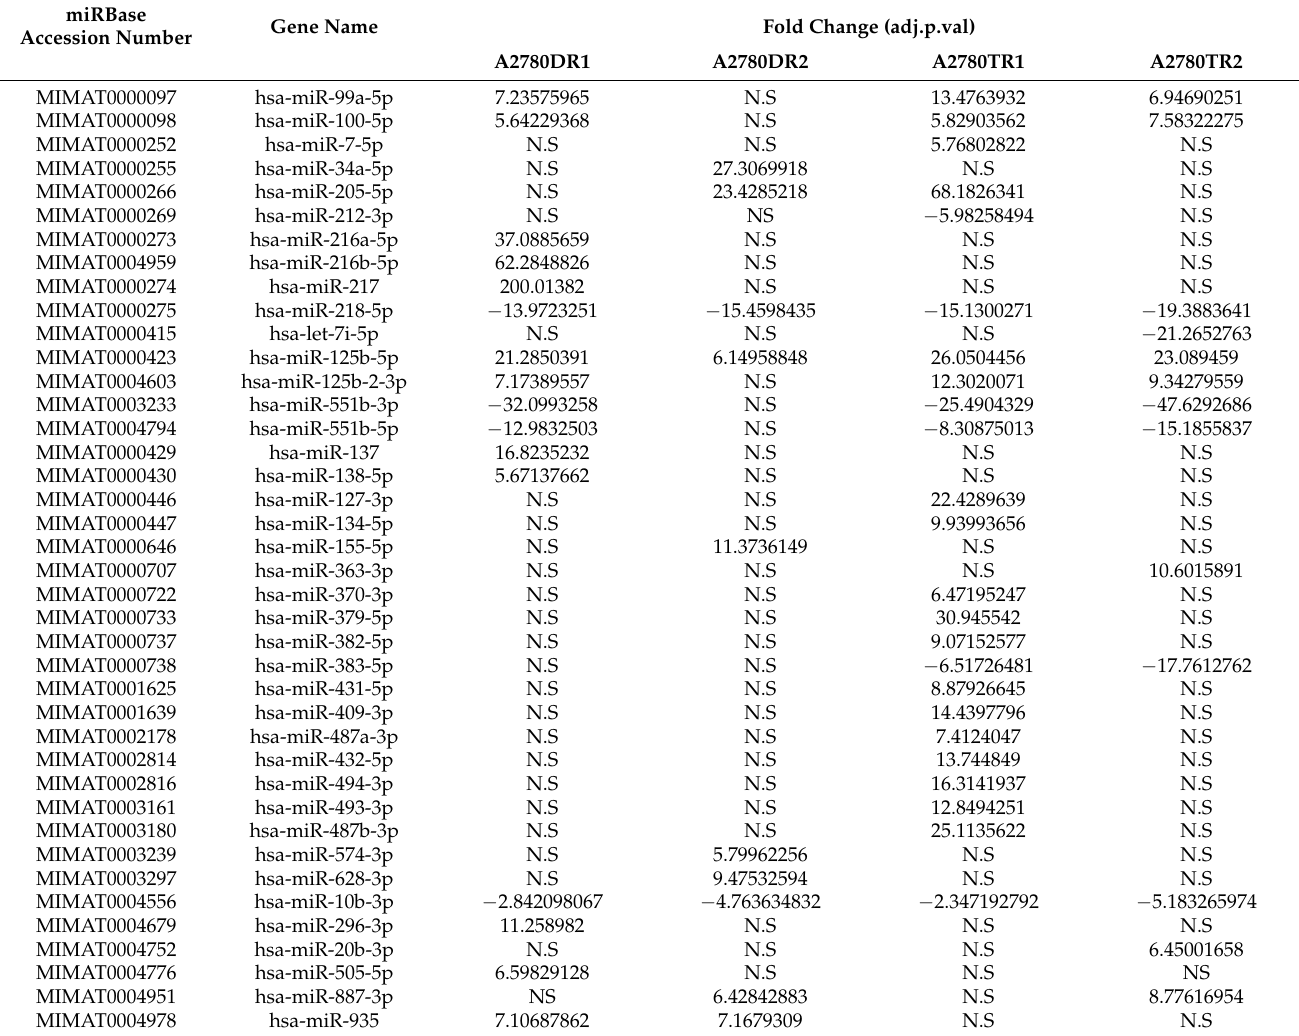
Table 1. List of the miRNA fold changes and false discovery rate (FDR) corrected p -values (adj.p.val.). Each comparison was performed in relation to A2780 cells. N.S: up/downregulation between 5 and − 5, or insignificant